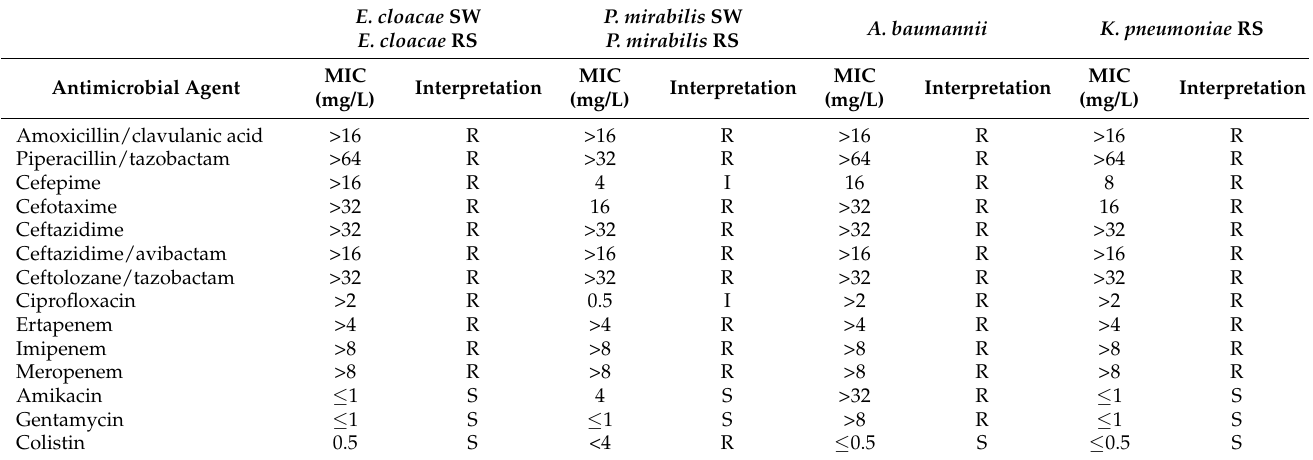
Table 1. Susceptibility profile of isolates obtained from surgical wound (SW) and rectal swab